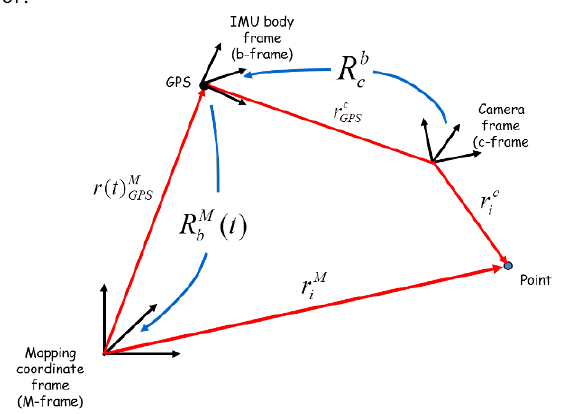
Figure 2. Direct georeferencing